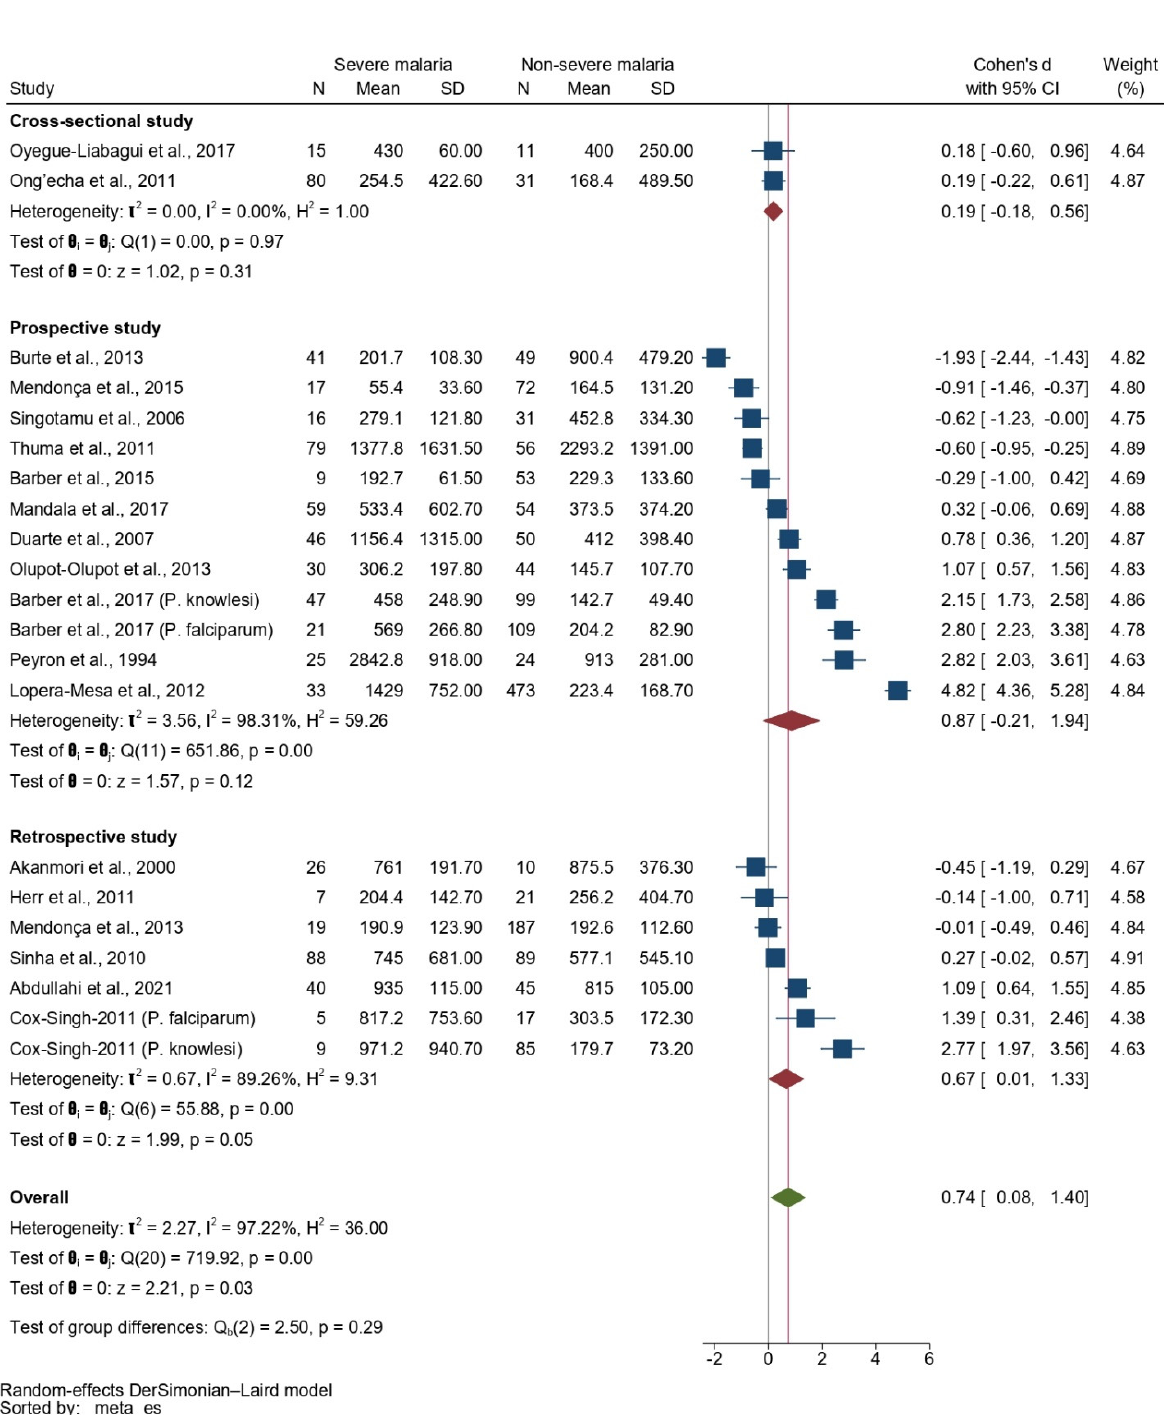
Figure 3. Forrest plot showing the SMDs of IL-10 levels between patients with severe malaria and non-severe malaria stratified by study design. Abbreviations: CI, confidence interval; SD, standard deviation. Symbols: blue square, point estimate (SMD of IL-10); green diamond, pooled effect estimate (pooled SMD of IL-10); red diamond, pooled effect estimate in each